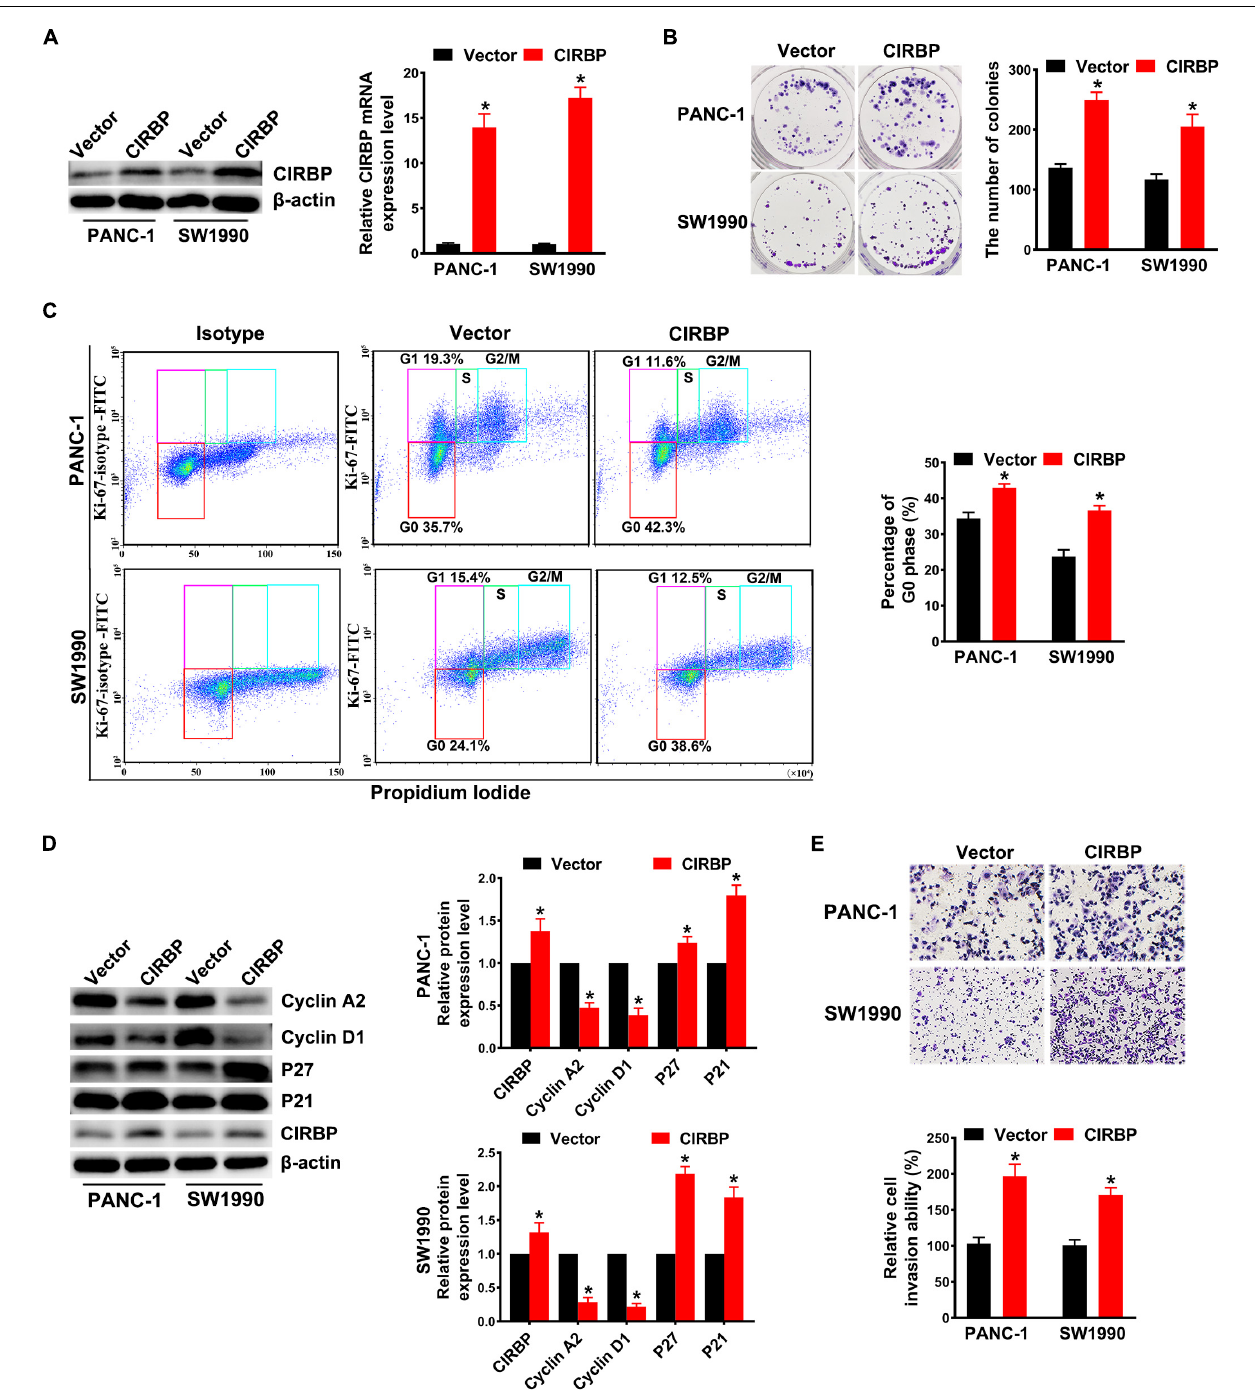
FIGURE 3 | Overexpression of CIRBP promotes the invasion and cell cycle of pancreatic cancer cells in vitro . (A) The interference efficiency of the lentiviral carrying CIRBP was validated by Western blot and RT-qPCR analysis. (B) The effects of CIRBP overexpression on the colony formation of pancreatic cancer cells. (C) Cell cycle of PANC-1 and SW1990 cells with CIRBP overexpression was analyzed by Ki-67 and propidium iodide stainings. Ki-67 antigen is rarely detected in G0 phase, but highly expressed in the proliferating cells (G1, S, G2, and M phases). G0 (red, lower boxes) and G1 (purple, upper left boxes) cells exhibit 2N DNA, S phase cells (green) exhibit 2N-4N DNA and G2/M cells (blue) exhibit 4N DNA. The experiments were performed on the same day and the data were analyzed with the same gating. The isotype was used as negative control. (D) Western blot analysis of cyclin D1, cyclin A2, p27 and p21 in CIRBP overexpression PANC-1 and SW1990 cells. β -actin was used as a loading control. (E) The invasion of PANC-1 and SW1990 cells with CIRBP overexpression were determined by transwell assays. Data are presented as means ± SD. * P < 0.05, unpaired student’s t -test.